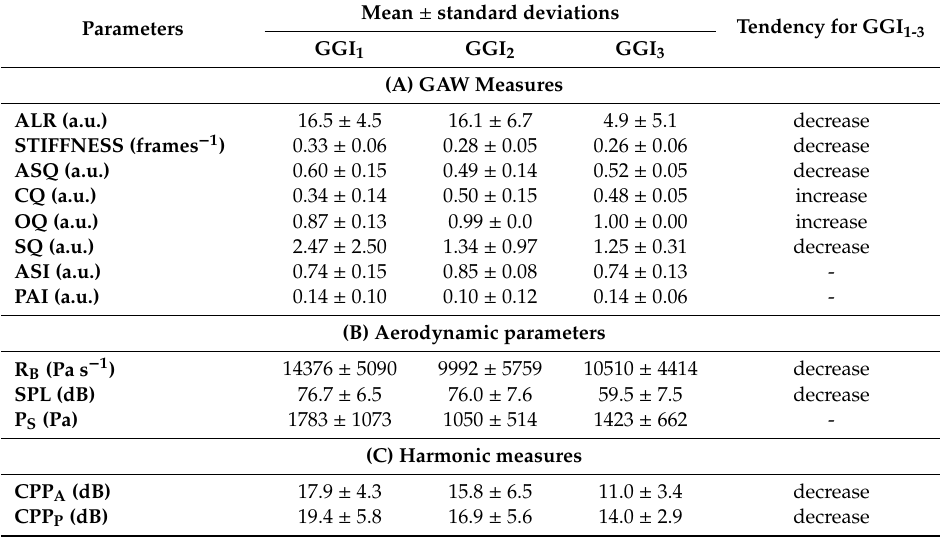
Table 5. Mean values and standard deviations for the GAW, aerodynamic and harmonic measures of the three di ff erent GGI groups with